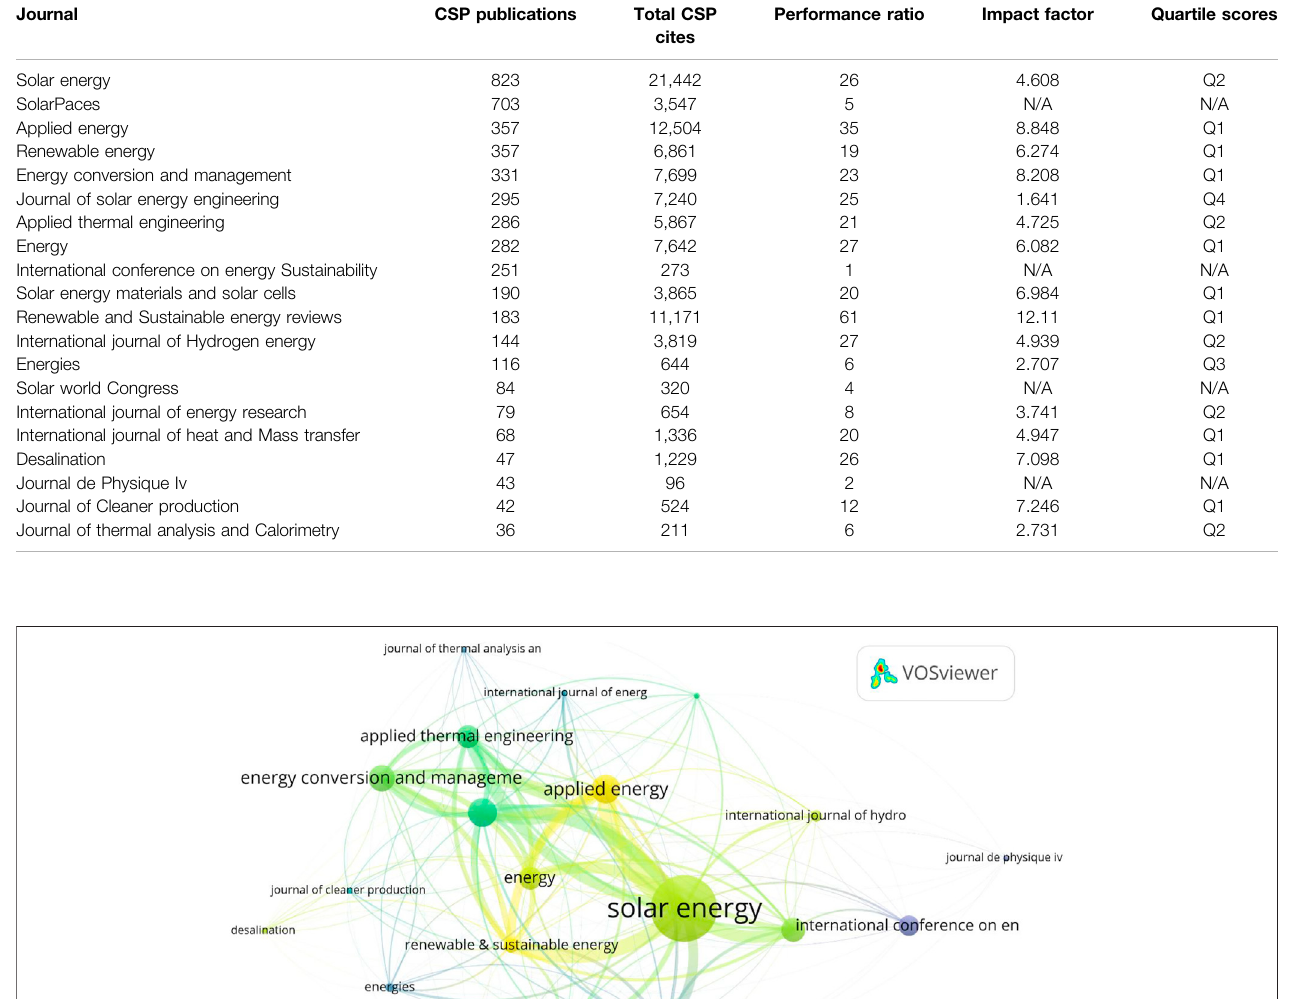
TABLE 6 | Top 20 journals in CSP fi eld.